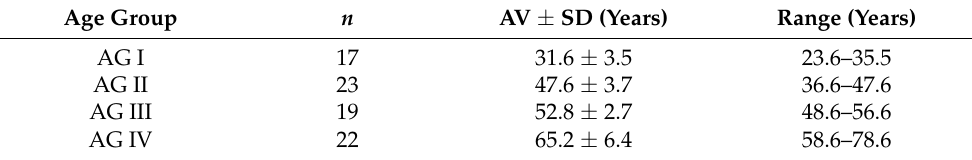
Table 1. Allocation of age groups.